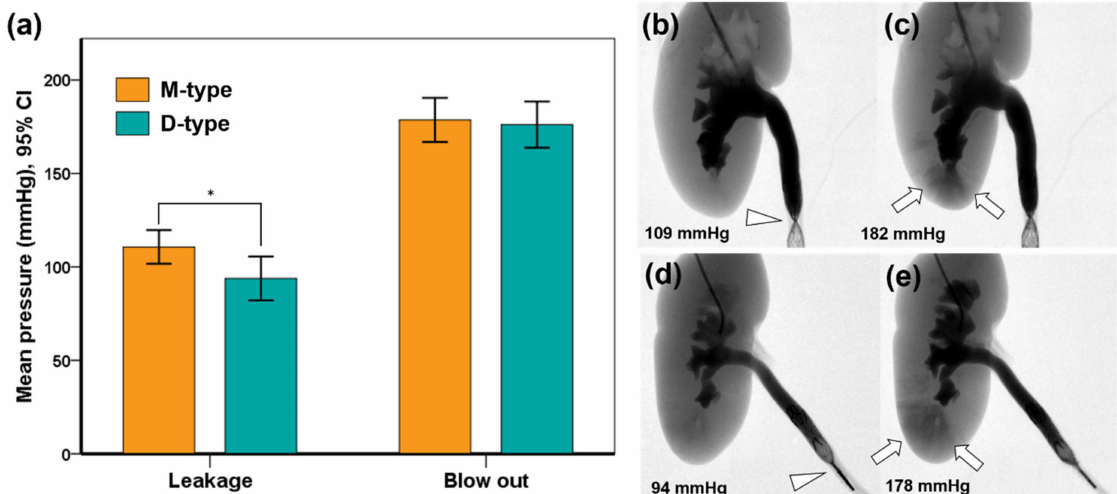
Figure 4. Results of ex vivo experiments. ( a ) Graphs showing the mean pressures at the point of leakage and blowout in the M-type and D-type occlusion self-expandable metallic stents (SEMSs). Fluoroscopic images obtained during the ex vivo experiment using the M-type occlusion SEMS showing ( b ) leakage (arrowhead) at 109 mmHg and ( c ) blowout (arrows) at 182 mmHg. Fluoroscopic images showing ( d ) leakage (arrowhead) at 94 mmHg and ( e ) blowout (arrows) at 178 mmHg in the D-type occlusion SEMS. Note: CI, confidence interval. * p <